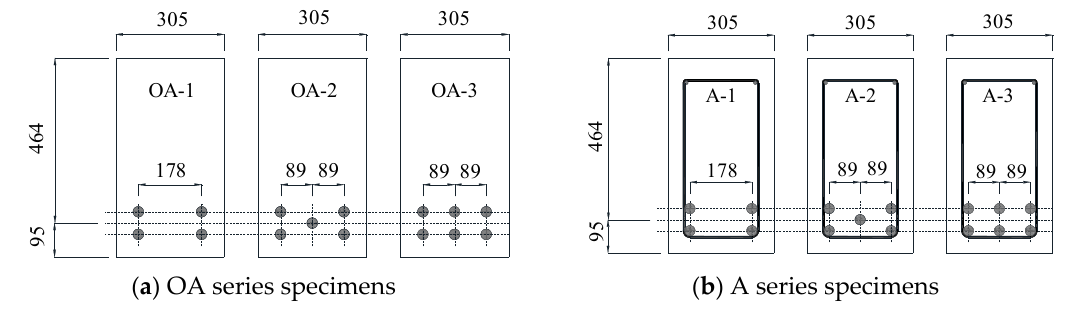
Figure 8. Beam cross-sections (Unit: mm). Table 1. Dimensions and material properties of test specimens.